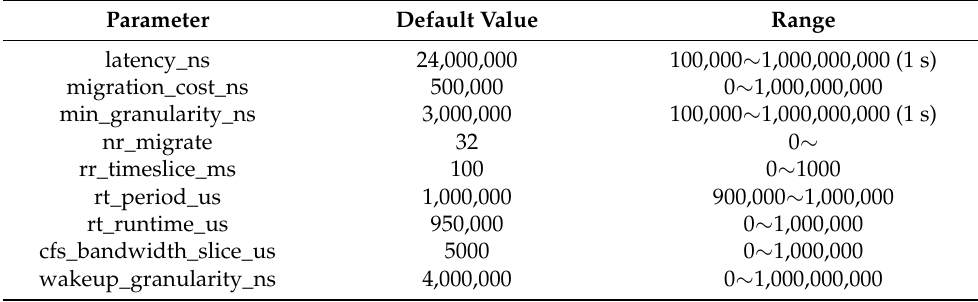
Table 1. Initial settings of 9 scheduler parameters and modifiable ranges.